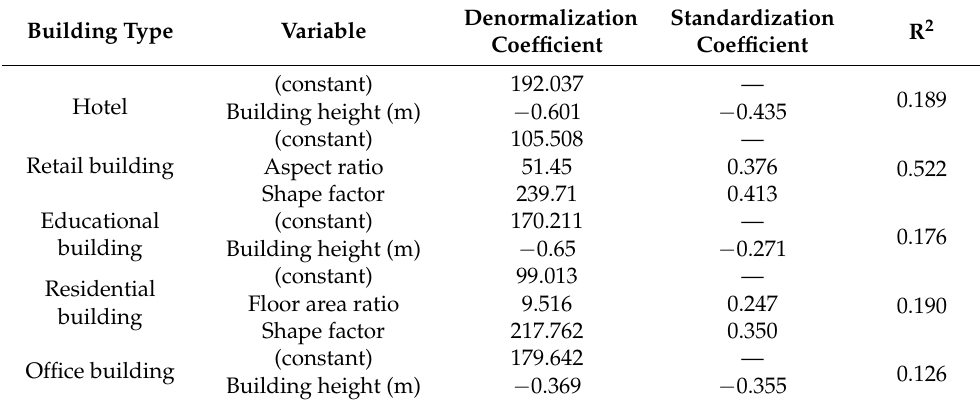
Table 5. Stepwise regression results of urban morphology factors and building heating EUI.